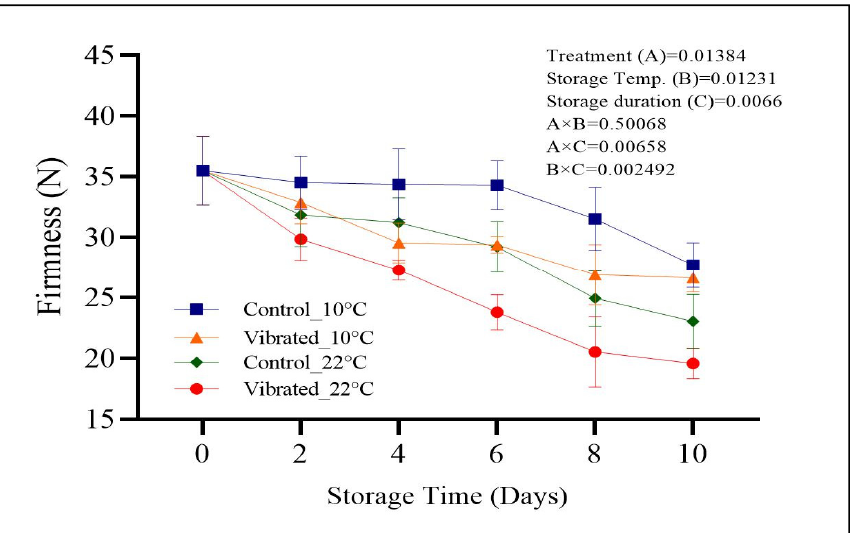
Figure 10. Firmness value (b*) of vibrated and non-vibrated (control) tomatoes stored at 10 °C and 22 °C for 10 days storage. Error bars represent the standard deviation (SD) of the mean values ± S.D of 6 readings per 3 replicates. The zero-order kinetic model was successfully fitted to experimental data of firmness reduction values of both vibrated to control tomato groups stored at 10 °C (Table 2). How- ever, the first-order model gave the highest coefficient of determination ( R 2 ) and low chi-